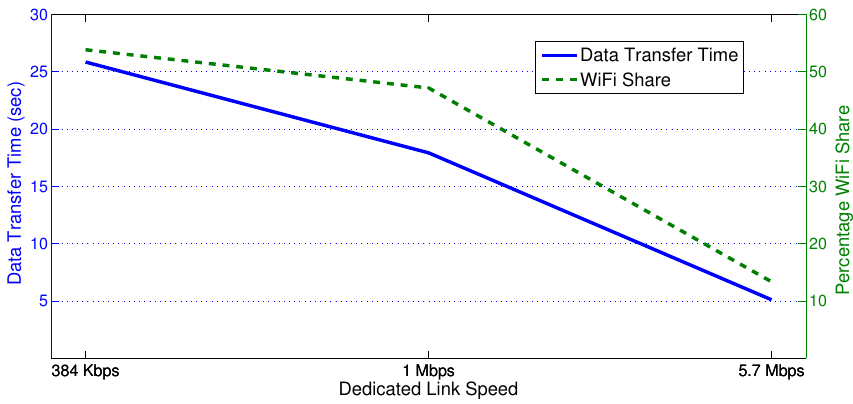
Figure 3. Data transfer time and the percentage of WiFi